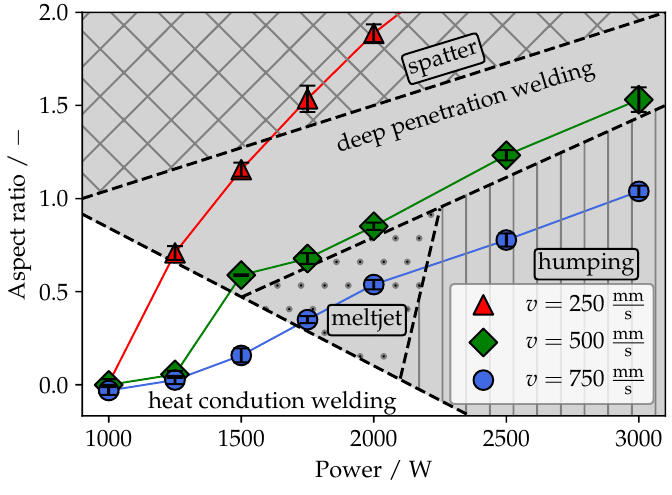
Figure 9. Comparison of the aspect ratios based on the capillary depth measurement ( n = 6 )